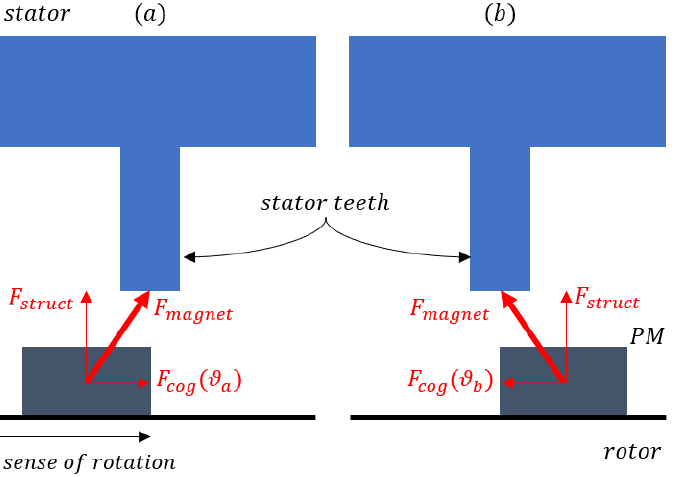
Figure 1. Schematic representation of the magnetic stator-rotor interaction. The interaction force changes from being in favour of the direction of rotation ( a ) to being against the direction of rota- tion ( b